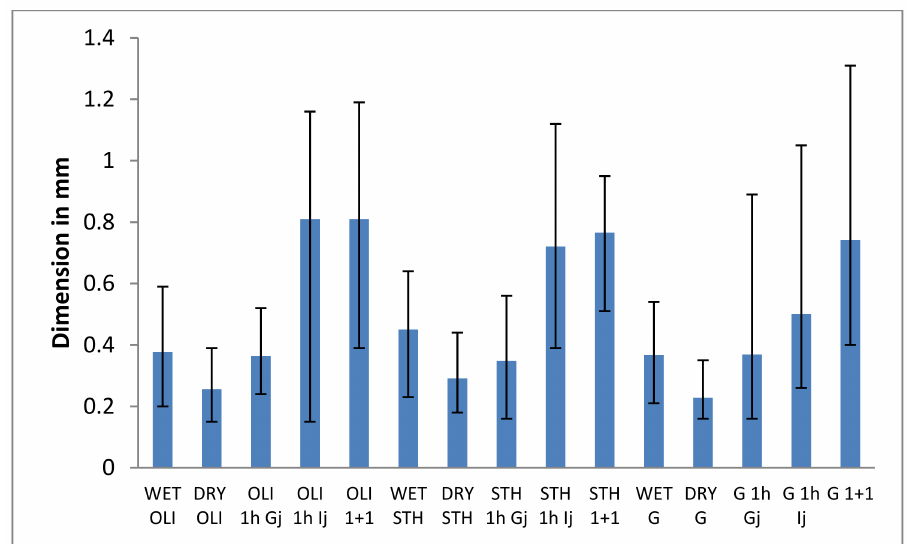
Figure 4. The effect of simulated gastrointestinal juices on the size of the microcapsules. Each bar presents the mean of three replicates. OLI—Microcapsules with oligofructose, STH—Microcapsules with starch, g—Microcapsules with glucose, INU—Microcapsules with inulin, 1 h gj—Microcapsules that stood for one hour in simulated gastric juice at 37 ◦ C, 1 h Ij—Microcapsules that stood for hour in simulated intestinal juice at 37 ◦ C, 1 + 1—Microcapsules that stayed one hour in gastric juice then one hour in intestinal juice at 37 ◦